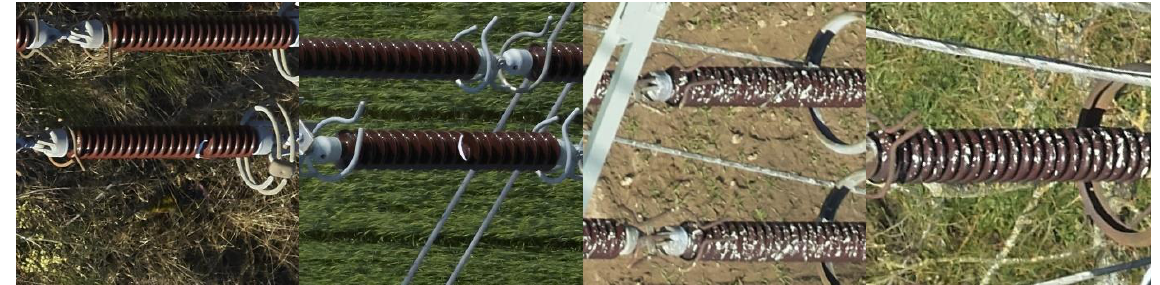
Figure 7. Sample images of insulators with defects and surface contaminations.